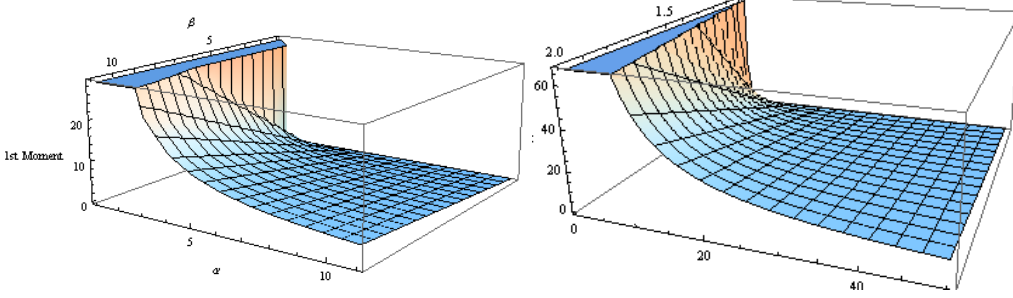
Figure 4. Sensitivity of the first moment under the Gaussian copula at θ = 0 and θ = − 0 . 9 with respect to claim size and inter-claim time averages.